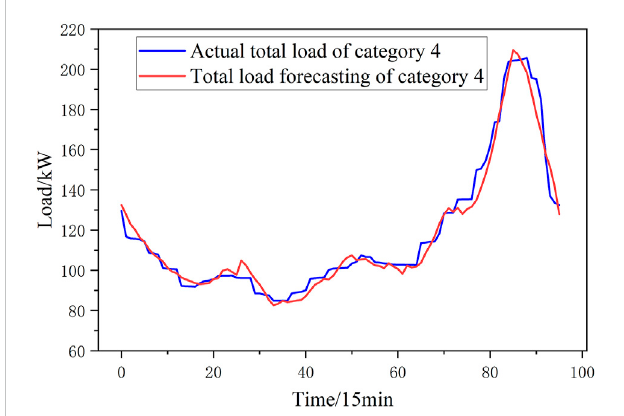
FIGURE 16 Comparison of total load between mothod in this paper and forecasting without